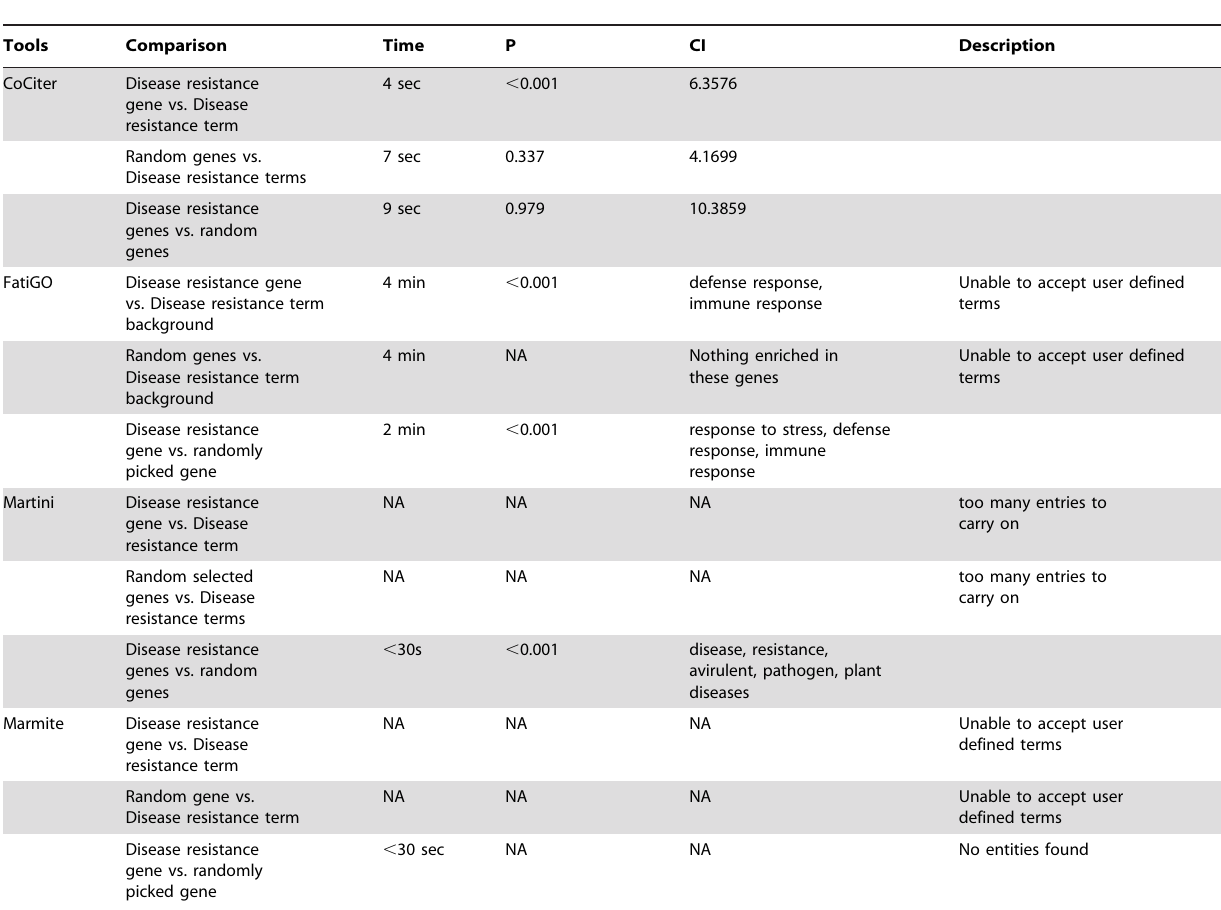
Table 2. Performances of CoCiter, FatiGO, Martini and Marmite on the disease resistant and randomly selected dataset.